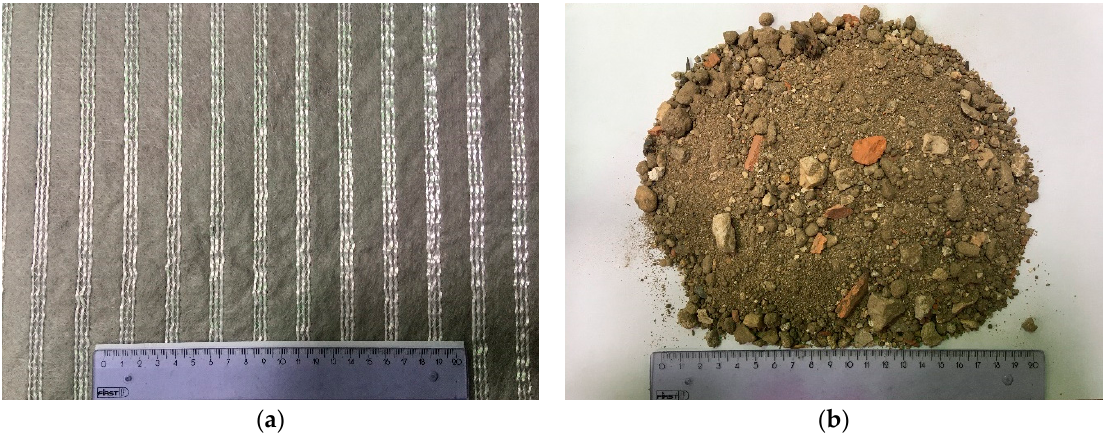
Figure 1. Materials used in the study: ( a ) High-strength geotextile; ( b ) Recycled C&D material.